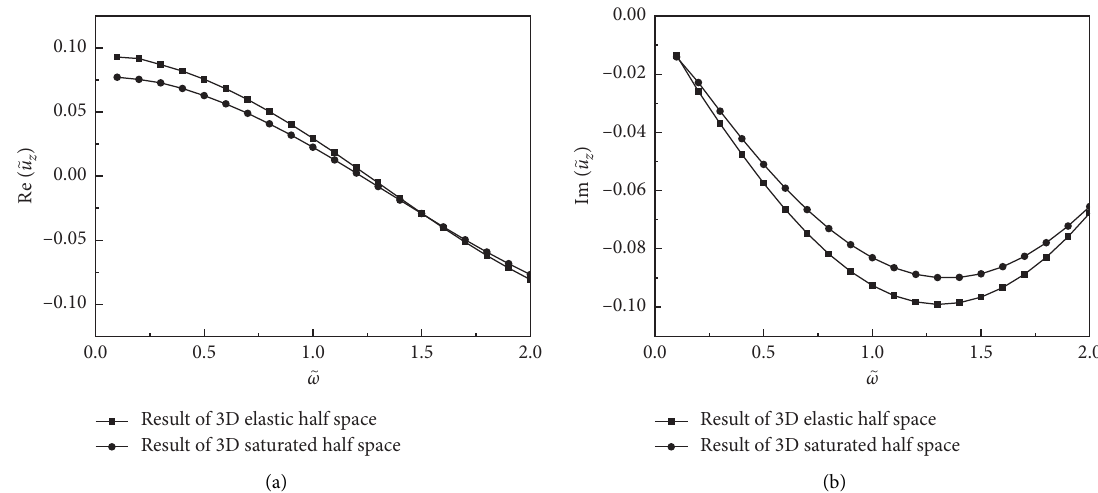
Figure 5: The vertical displacement for the 3D half-space varied with the frequency: (a) real part of vertical displacement and (b) imaginary part of vertical displacement.